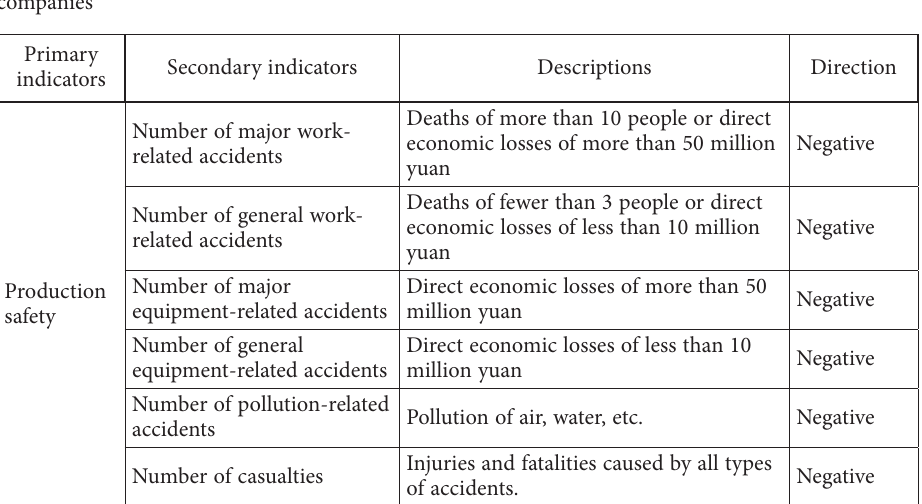
Table 2. Evaluation indicator system for sustainable development capacities of listed electric power